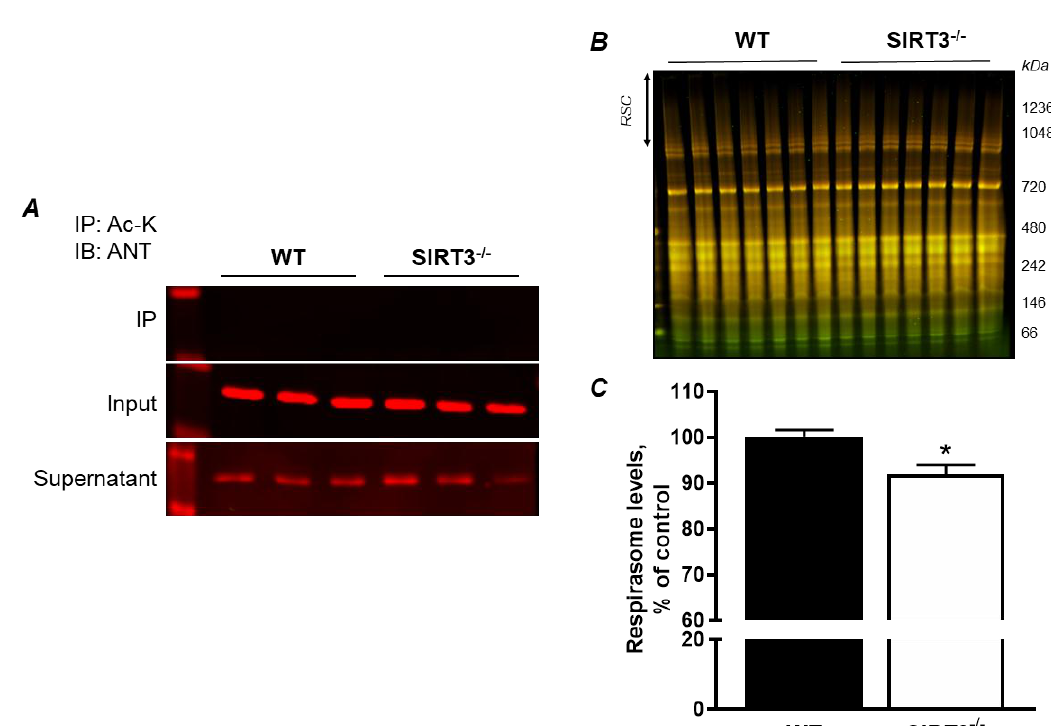
Figure 5. ANT1 is not acetylated but acetylation of mitochondrial proteins stimulates RCS disassembly in SIRT3 KO mitochondria. ( A ) Immunoprecipitation (IP) of liver mitochondrial proteins with acetylated lysine (Ac-K) antibodies followed by immunoblotting (IB) against ANT1. Input: the sample before IP; Supernatant: sample that did not bind to Ac-K antibodies; ( B ) BN-PAGE gel of liver mitochondria isolated from WT and SIRT3 KO − mice. ( C ) Quantitative data of respirasome levels. The data were normalized to total protein levels and presented as percent change from the WT group. * P < 0.01 vs. WT; n = 6–7 animals per group.